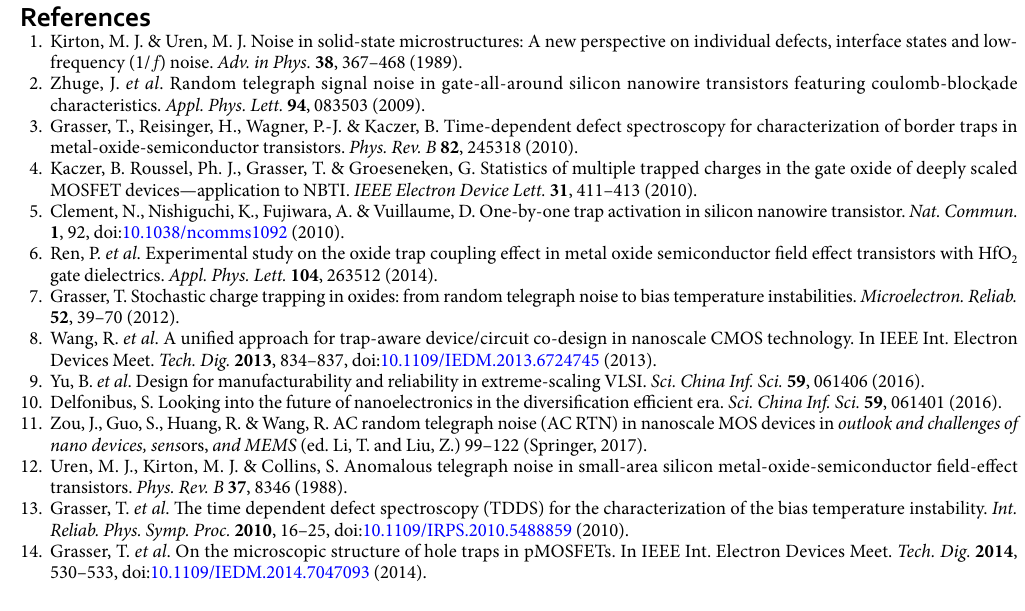
(or, 2 ↔ 1 ′ ) are preferred rather than between 1 ↔ 1 ′ (or, 2 ↔ 2 ′ ). Once the trap state turns to the zone A, it will